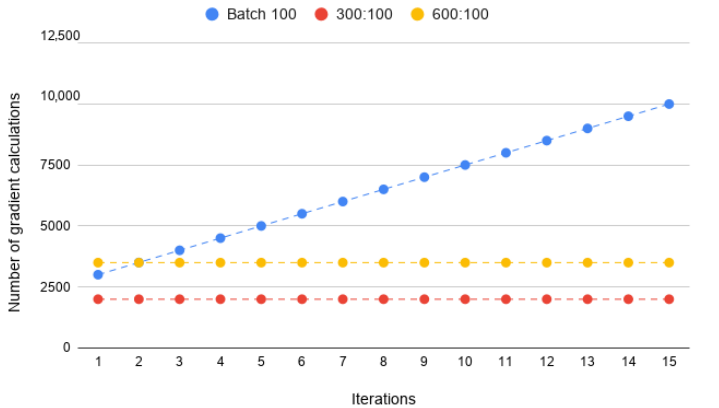
Figure 13. Number of gradient calculations for batch 100, 300:100, and 600:100